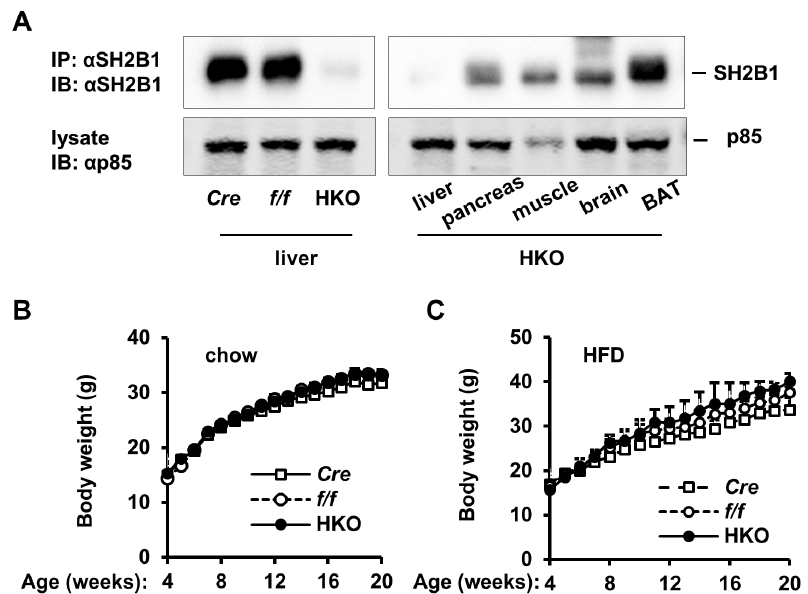
Figure 2. Hepatocyte-specific deletion of SH2B1 does not increase body weight. (A) Tissue extracts were prepared from the indicated male mice (7 weeks of age) and immunoprecipitated (IP) and immunoblotted (IB) with anti-SH2B1 antibody (upper panels). Tissue extracts were also directly immunoblotted with antibody against the p85 subunit of the PI 3-kinase (lower panels). (B) Growth curves of male mice fed a normal chow diet. f/f : n=9; Cre : n=5; HKO: n=9. (C) Growth curves of male mice were fed a HFD (from 7–20 weeks of age). f/f : n=5; Cre : n=5; HKO: n=6. Data are presented as means 6 SEM. P , 0.05.